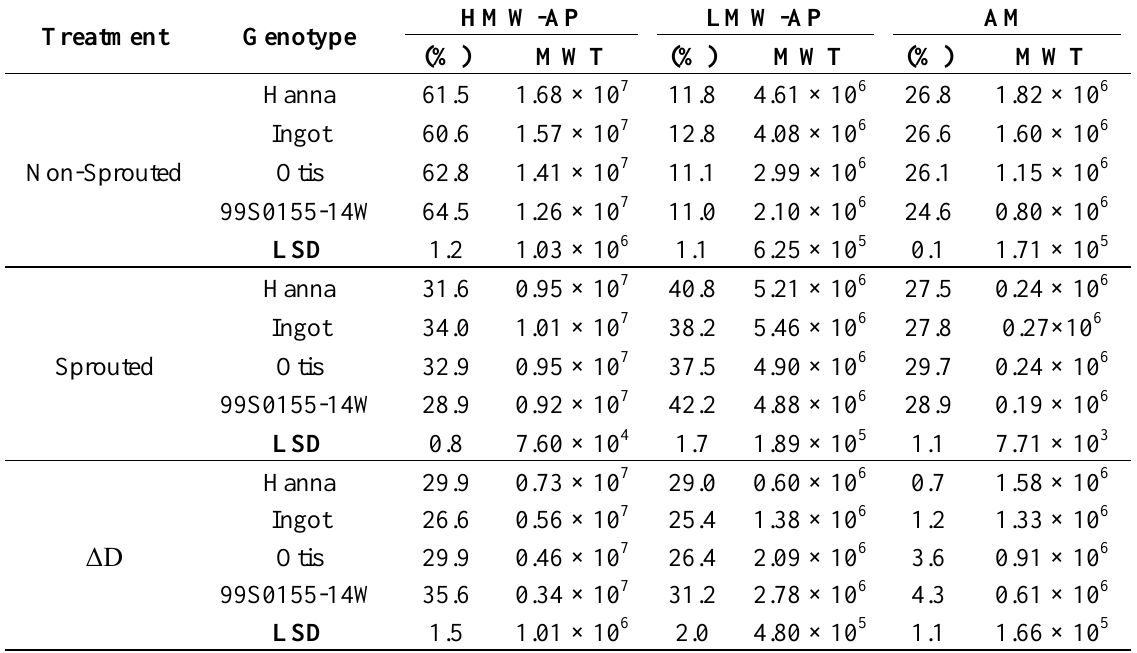
Table 4. Percent of starch fractions and molecular weight distribution (MWD) of HMW-AP, LMW-AP and AM from genotypes Hanna and Ingot (HRSW), Otis and 99S0155-14W